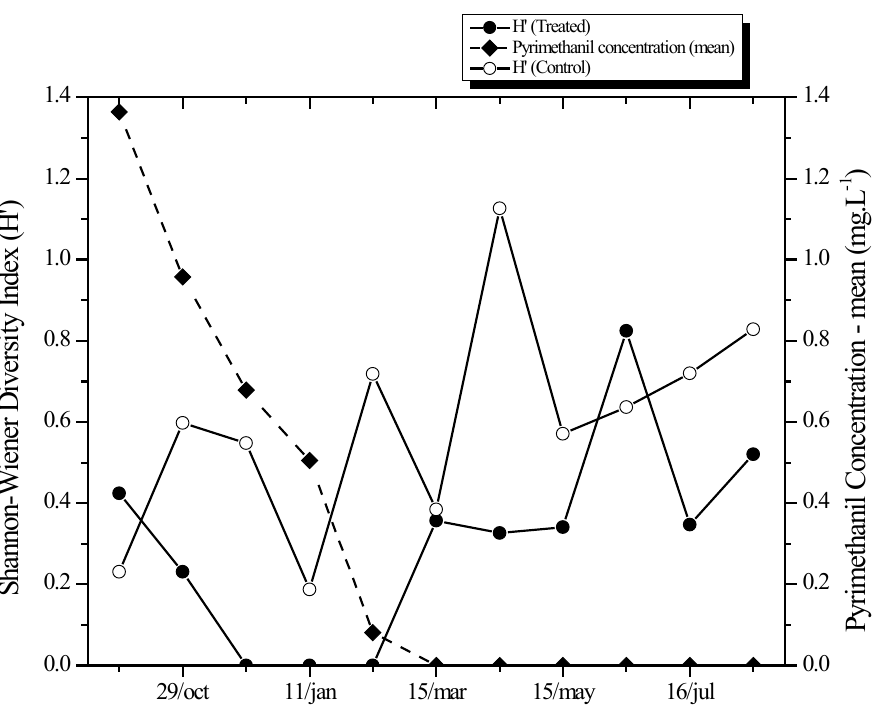
Figure 4. Shannon- Wiener diversity index mean